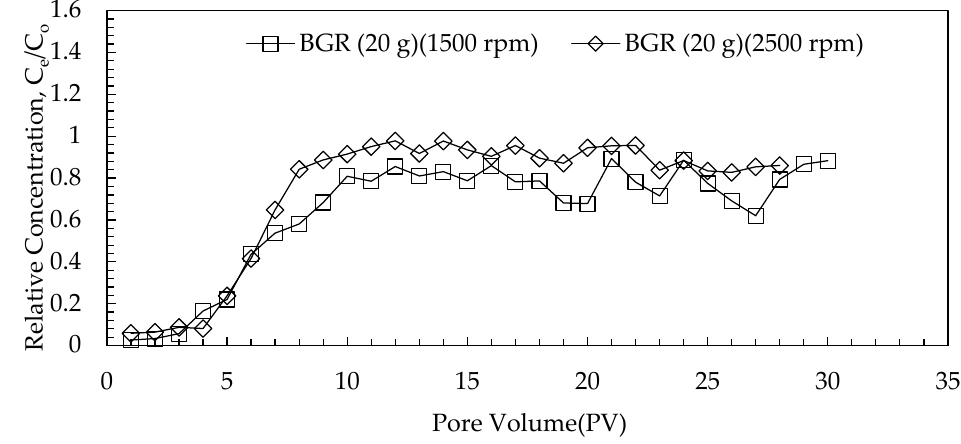
Figure 7. The effect of different g-forces on the migration of Cd in soil column. Note: 1500 rpm (520× g ) and 2500 rpm (1440× g ).